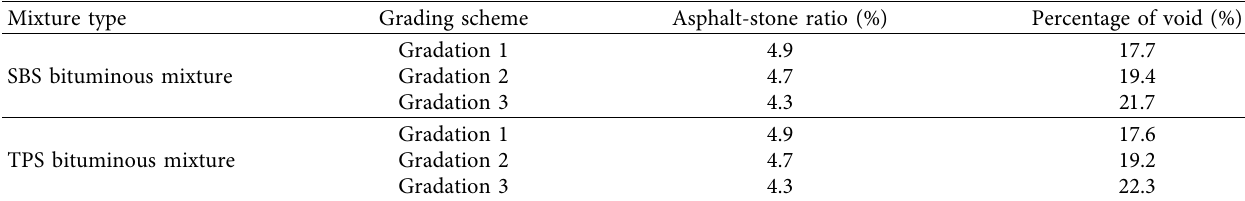
Table 7: Mineral aggregate gradation of OGFC-13 asphalt mixture.